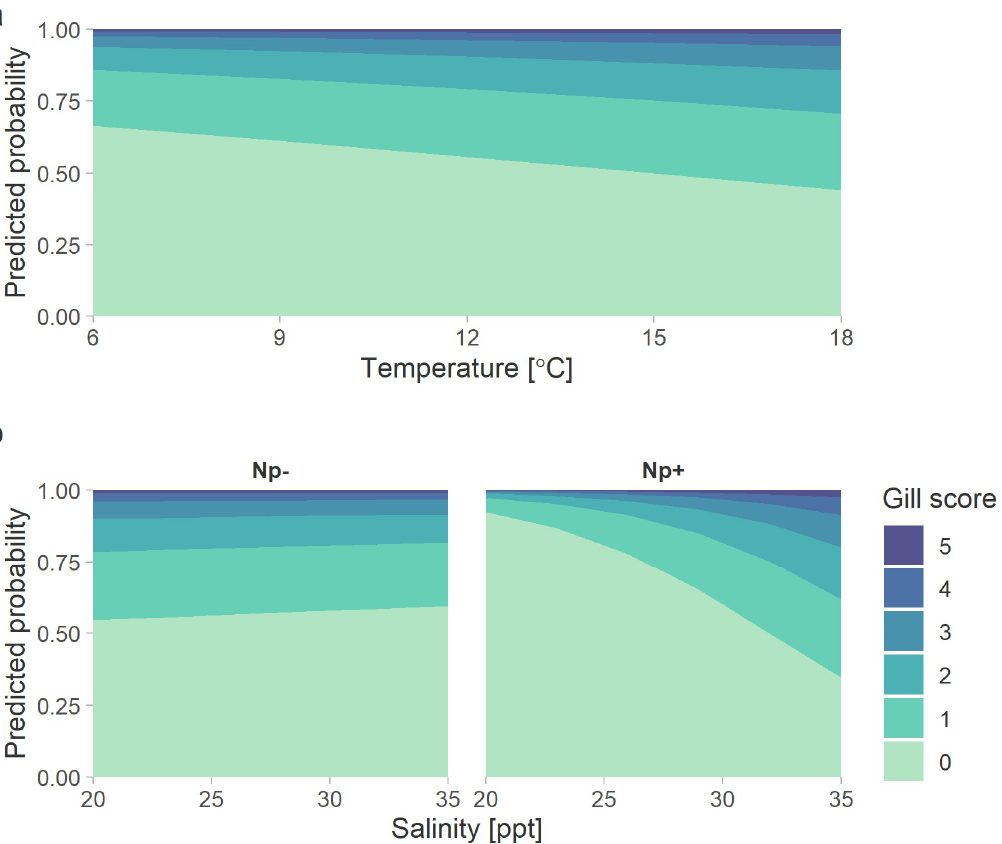
Figure 3. The effects of ( a ) temperature and ( b ) salinity in the absence (Np-) or presence (Np+) of Neoparamoeba perurans on the probability of gross gill scores, as predicted by the ordinal logistic model. See Table 1 for gill score criteria.